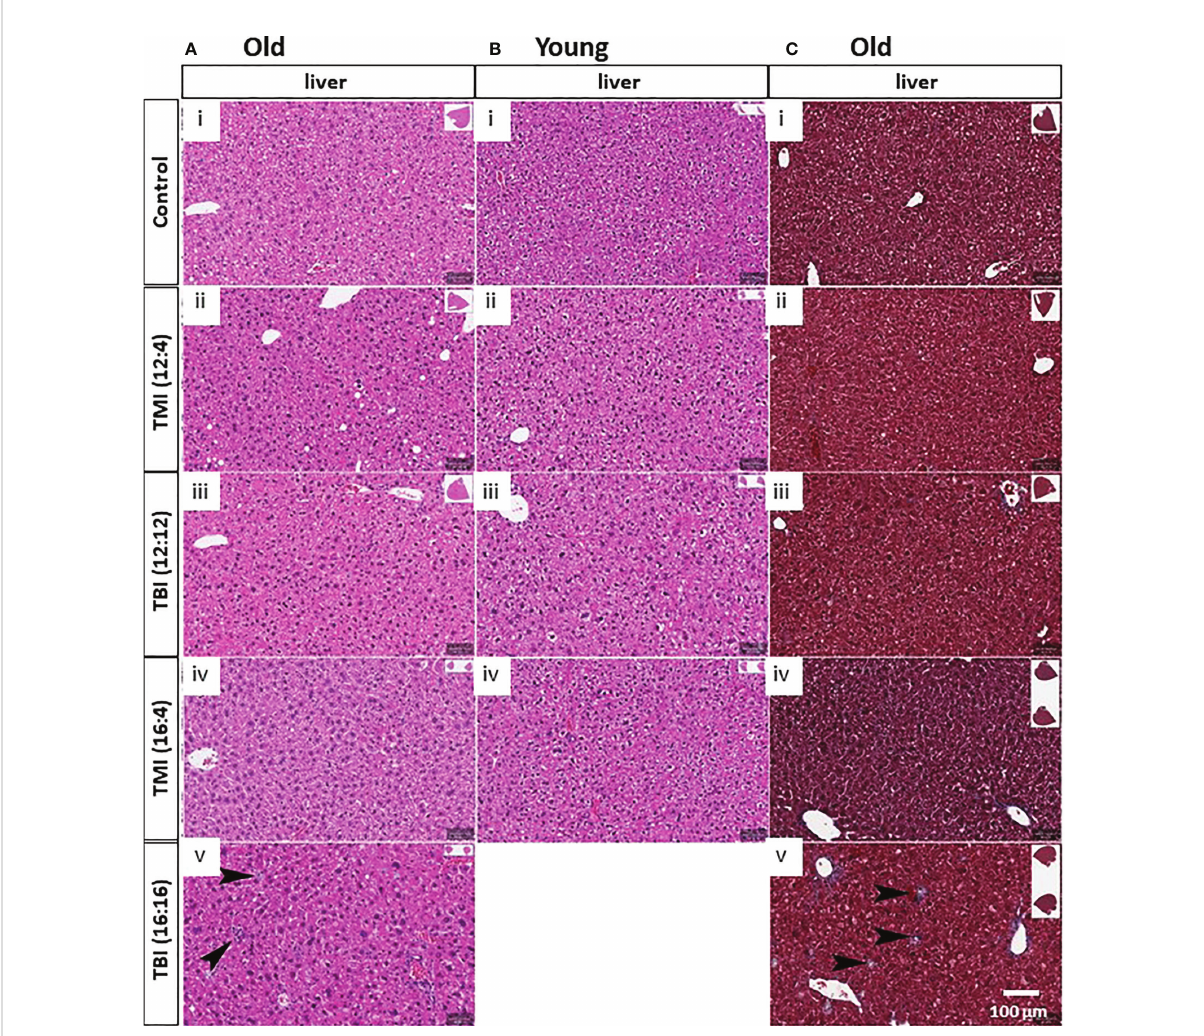
FIGURE 4 Damage of liver in TMI, TBI and untreated control in young and old mice at 12 weeks after BMT. (A) Liver histopathology in old mice. With TBI (16:16), there was increased portal in fl ammation and hepatocytes (arrows) present consistent with hepatocyte damage and turnover. Nuclear pleomorphism in the hepatocytes can be seen with increased radiation dosage. (i) Old control, (ii) TMI (12:4), (iii) TBI (12:12), (iv), TMI (16:4) and (v) TBI (16:16). (B) Liver histopathology in young mice. Increased nuclear pleomorphism in the hepatocytes can be seen with increased radiation dosage. (i) Young control, (ii) TMI (12:4), (iii) TBI (12:12), (iv), and TMI (16:4). (C) Trichrome staining in liver of old mice group. Increased fi brosis can be seen associated with the histocytes and portal in fl ammation. (i) Old control, (ii) TMI (12:4), (iii) TBI (12:12), (iv), TMI (16:4) and (v) TBI (16:16). Scale bar = 100 µm (A – C)